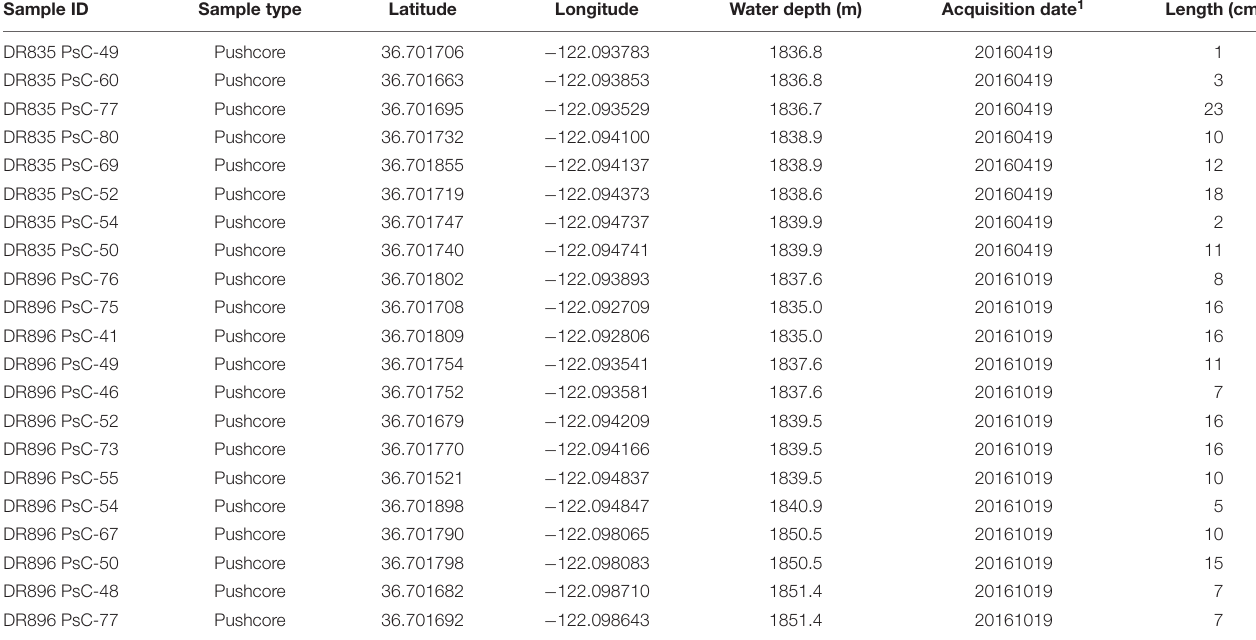
TABLE 3 | Remotely operated vehicle (ROV) Doc Ricketts pushcore samples analyzed for grain